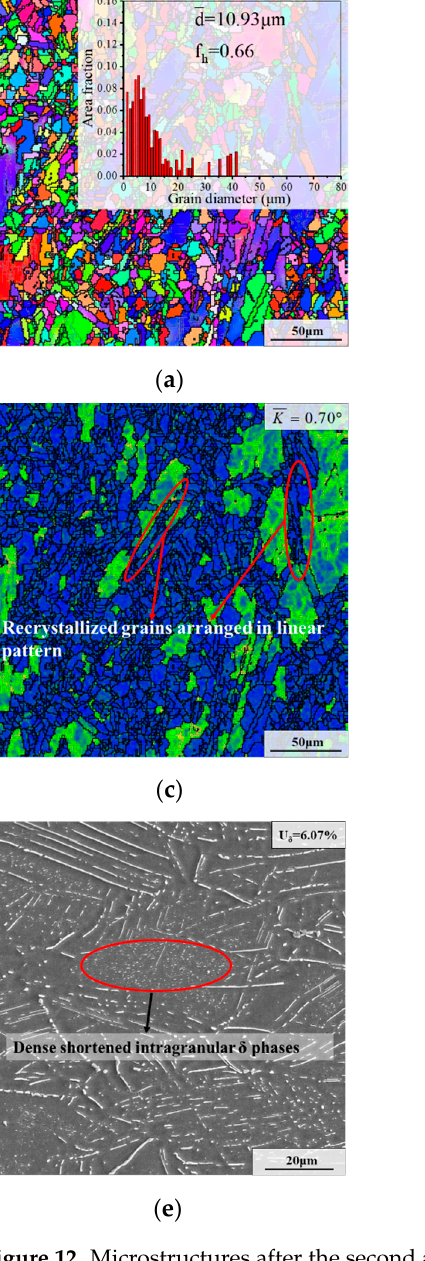
Figure 12. Microstructures after the second annealing stage with different true strains: ( a , c , e ) 0.36; ( b , d , f ) 1.20. (The deformation temperature was 950 °C; and the strain rate was 0.1 s − 1 ).